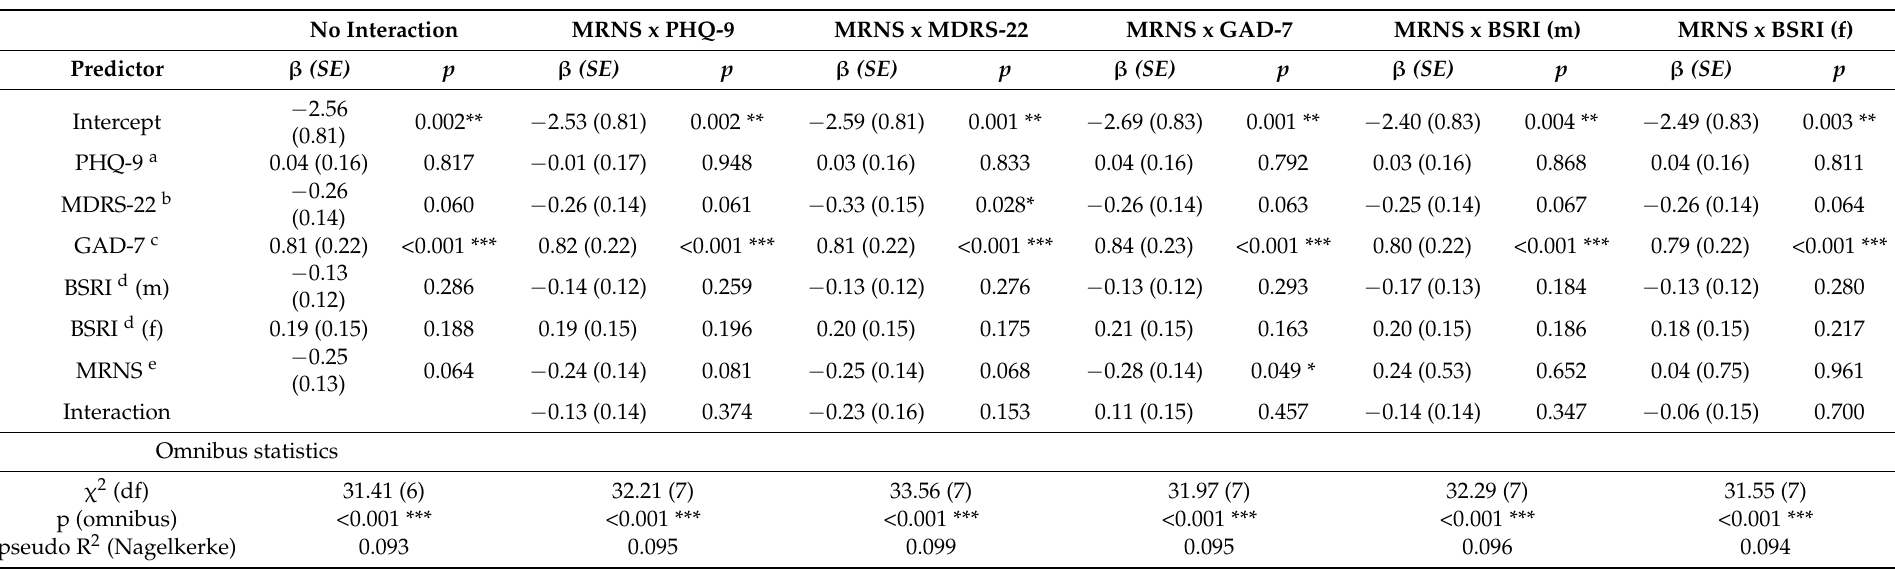
Table 4. Summary of the binary logistic regression models for the female